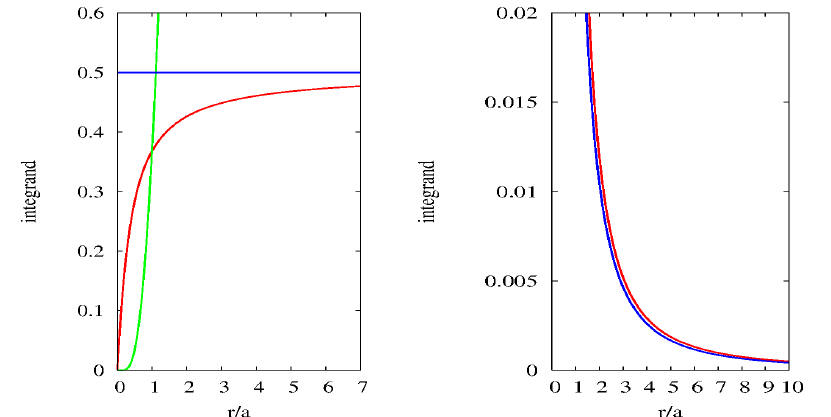
Figure 1. Typical factors in cluster integrals representing. Left panel: For repulsive ions exponential function (green), same function subtracting first two expansion terms (red), only second-order term (blue line). Right panel: exponential term subtracting the lowest power up to e 4 (in red) and the bare )) gives indeed a qualitatively correct overall shape. Note that all functions are term of order ( O ( ξ 4 ij multiplied with the spatial pre-factor x 2